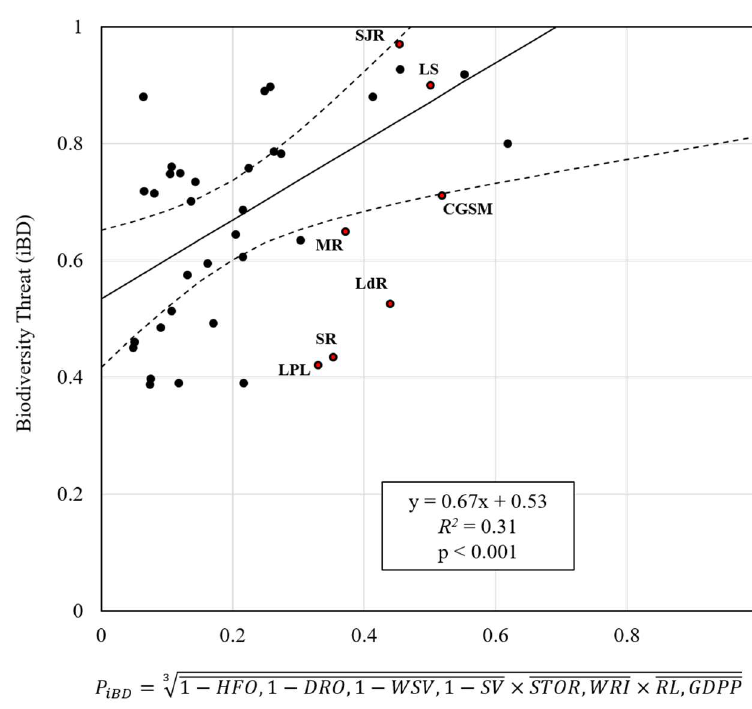
Figure 5. Strongest correlation for biodiversity-related threat benchmark, iBD (incident biodiversity threat; [14]), as a function of proxy ( P iBD ) obtained using external, internal and socioeconomic indicators (Table 2). Regression model (solid line; dashed lines 95% confidence interval) based on Ramsar sites (black circles), with SAFER sites (red circles) plotted for comparison.